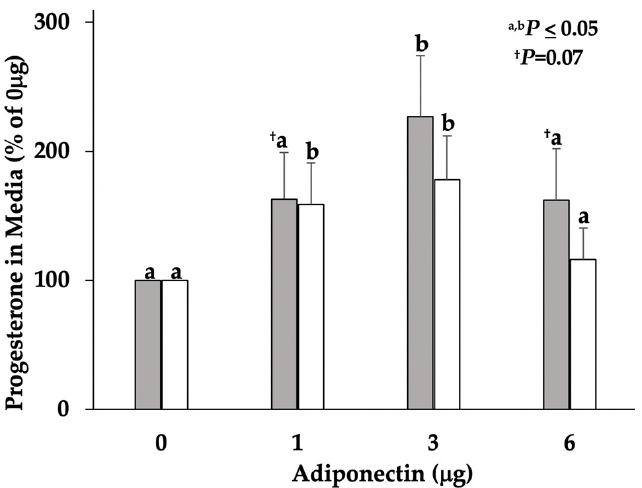
Figure 2. Concentrations of progesterone in aspirated culture media from D5 (shaded bars; n = 4) and D7 (open bars; n = 5) dispersed lutea cell cultures, following 24 h treatment with adiponectin (1, 3, and 6 µ g). Adiponectin treatment significantly increased ( p ≤ 0.05) secreted progesterone in D5 and D7 cultures in a bell-shaped dose response. a,b Different superscripts identify means relative to treatment dose of adiponectin, within day, that significantly differ ( p < 0.05) from control dose (0 µ g; no adiponectin). † Superscript identifies mean concentrations of progesterone relative to treatment dose of adiponectin, within day, that tended ( p = 0.07) to differ from control dose (0 µ g).